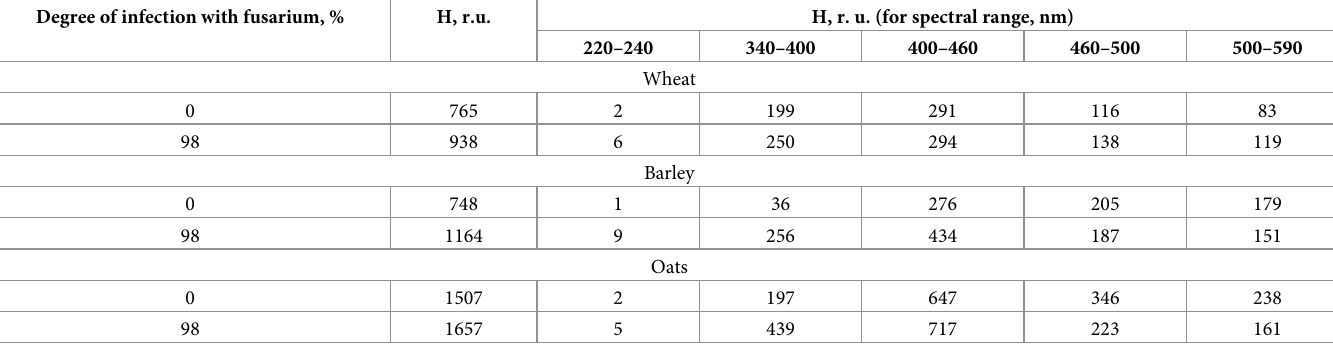
Table 1. Integral parameters of excitation spectra of plant seeds of various degrees of fusarium infection. Degree of infection with fusarium, % H,